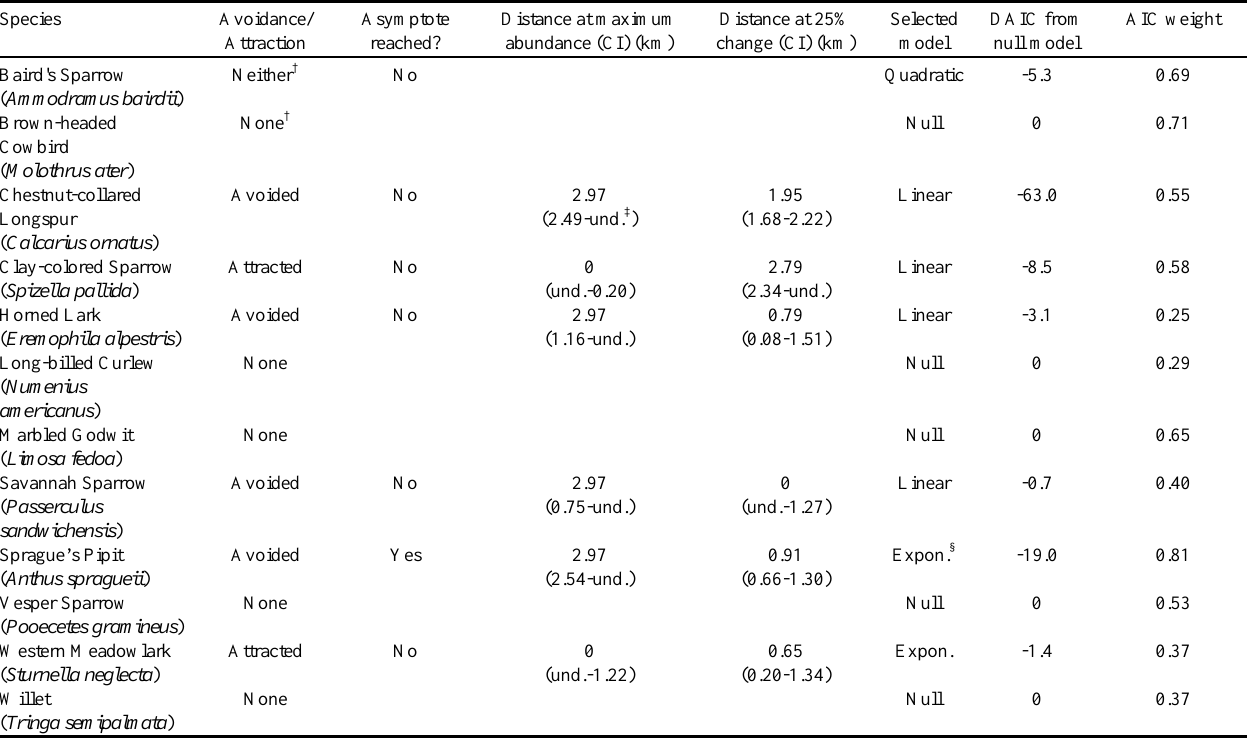
Table 2 . Effect of distance to cropland/forage on 12 bird species in Alberta, Canada, 2000-2002. Species